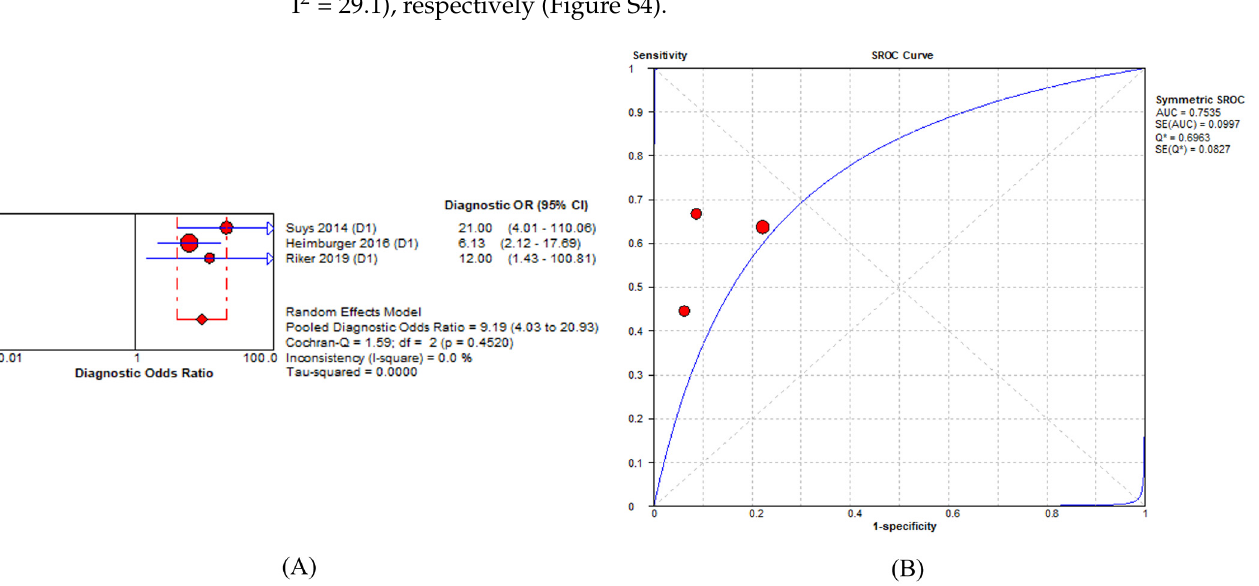
Figure 4. Prognostic accuracy of percent constriction of pupillary light reflex for a poor neurological outcome. ( A ) diagnostic odds ratio of percent constriction of pupillary light reflex in predicting a neurological outcome; ( B ) SROC curve of percent constriction of pupillary light reflex in predicting a neurological outcome. Abbreviations: CI, confidence interval; SD, standard deviation; SROC, summary receiver-operating characteristic.